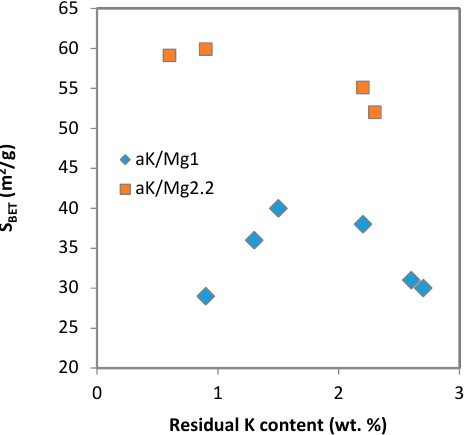
Figure 1. Dependence of specific surface area ( S BET ) on real K content in a K/Mg1 and a K/Mg2.2 catalysts.